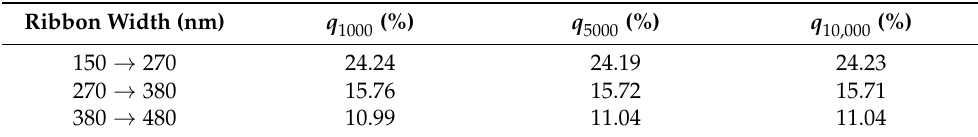
Table 9. Percentage variation in plasmon frequency by increasing ribbon width for selected momenta and at N 2 D = 4.0 × 10 12 cm − 2